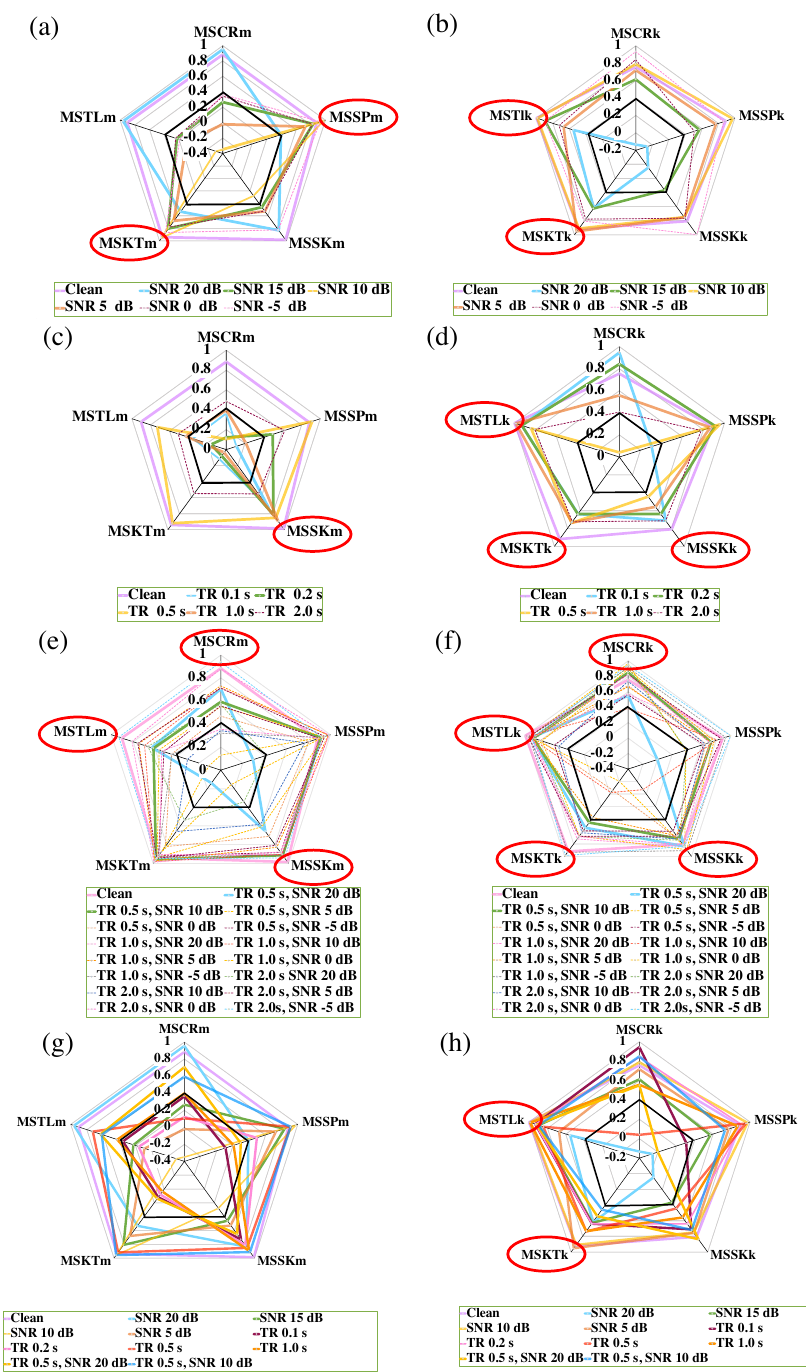
Figure 10. Radar charts of highest similarity of each MSF in clean/noisy/reverberant/ noisy − and − reverberant environments: ( a ) MSFs in acoustic − frequency domain in all noisy en- vironments, ( b ) MSFs in modulation − frequency domain in all noisy environments, ( c ) MSFs in acoustic − frequency domain in all reverberant environments, ( d ) MSFs in modulation − frequency domain in all reverberant environments, ( e ) MSFs in acoustic − frequency domain in all noisy re- verberant environments, ( f ) MSFs in modulation − frequency domain in all noisy reverberant en- vironments, ( g ) MSFs in acoustic − frequency domain in all daily environments, and ( h ) MSFs in modulation − frequency domain in all daily